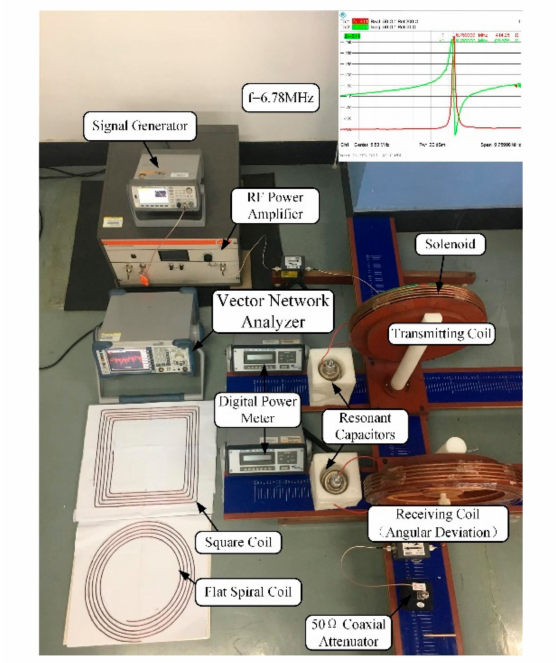
Figure 13. Experimental setup and